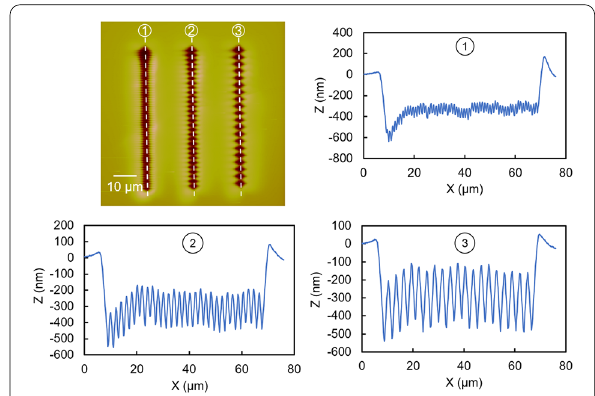
Figure 12 a AFM image and the corresponding cross-sections of the experimental results for the one array indentations with the rotation angle of 0° and the spacings of b 1 μm, c 2 μm and d 3